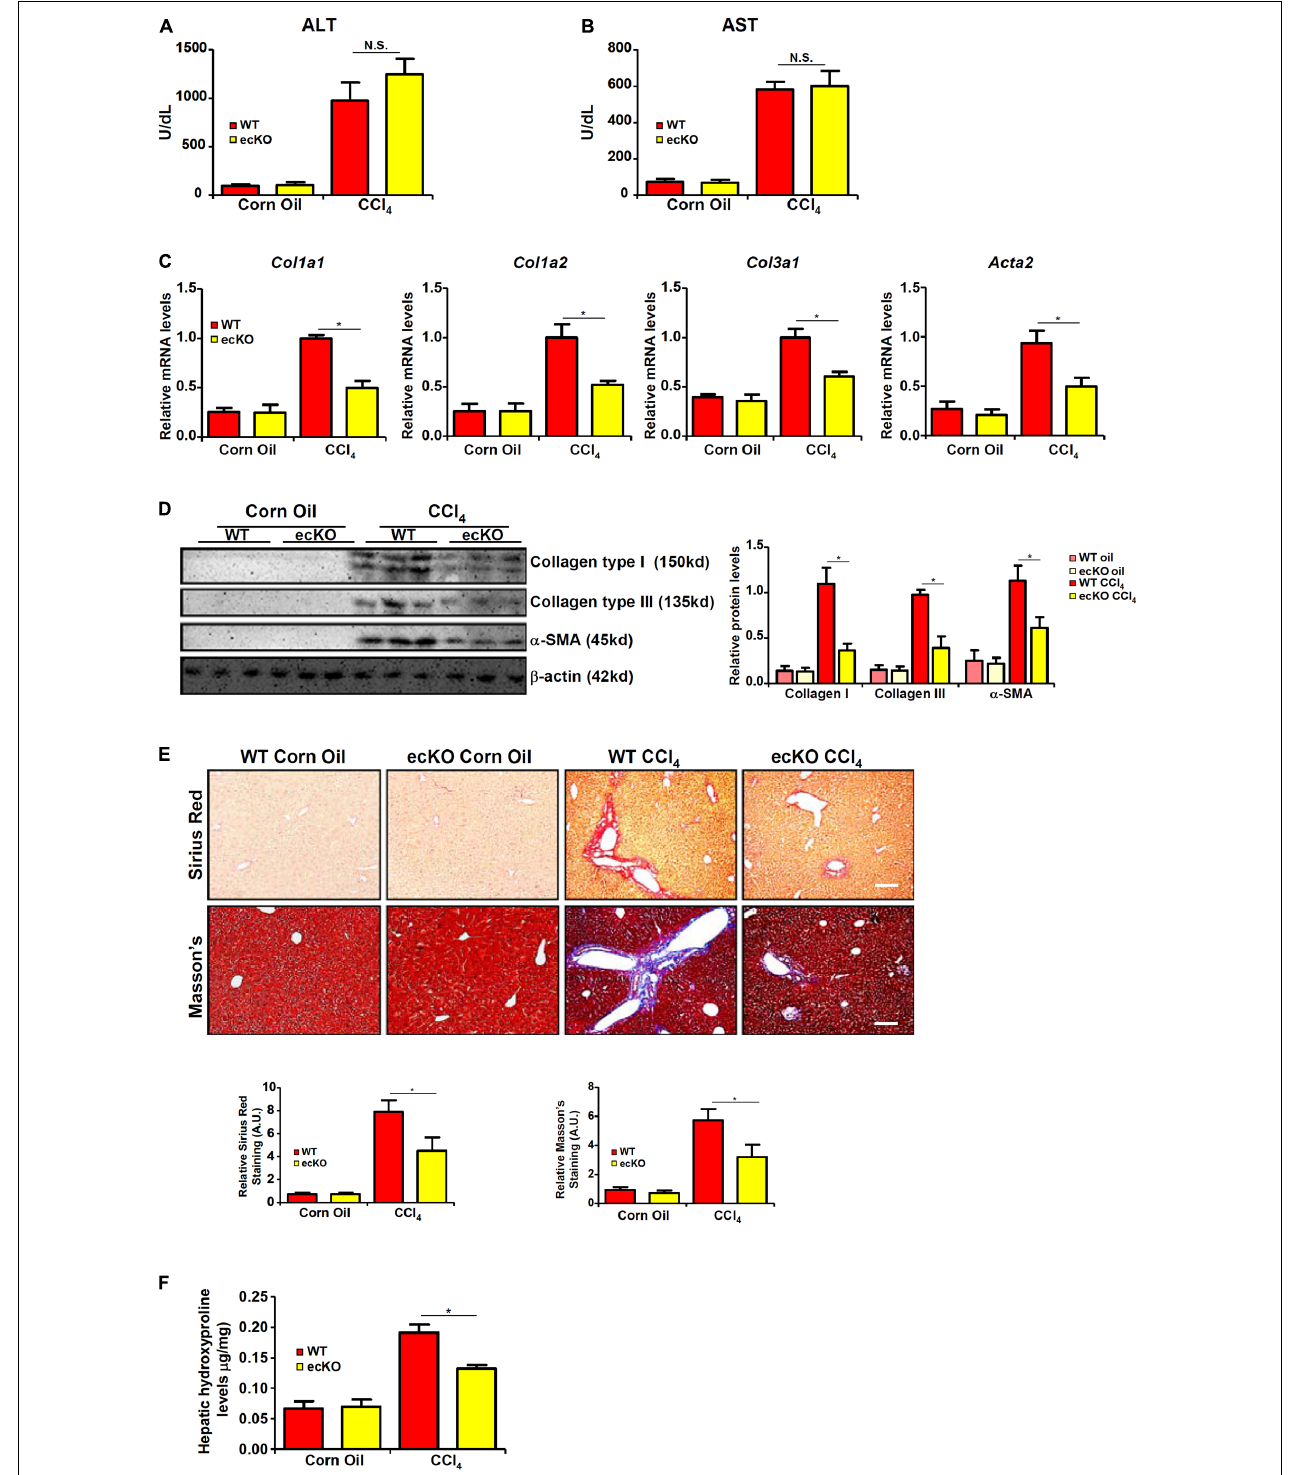
FIGURE 2 | Endothelial BRG1 deficiency attenuates liver fibrosis in mice. Liver fibrosis was induced in endothelial-specific BRG1 knockout mice (ecKO) and wild type (WT) mice by CCl 4 injection. (A) Plasma ALT levels. (B) Plasma AST levels. (C,D) Expression levels of pro-fibrogenic genes were examined by qPCR and Western. (E) Paraffin sections were stained with picrosirius red and Masson’s trichrome. (F) Hepatic hydroxylproline levels. N = 3 ∼ 4 mice for the corn oil groups and N = 6 ∼ 8 mice for the CCl 4 groups. Error bars represent SD (* p < 0.05, two-way ANOVA with post-hoc Scheffe test).